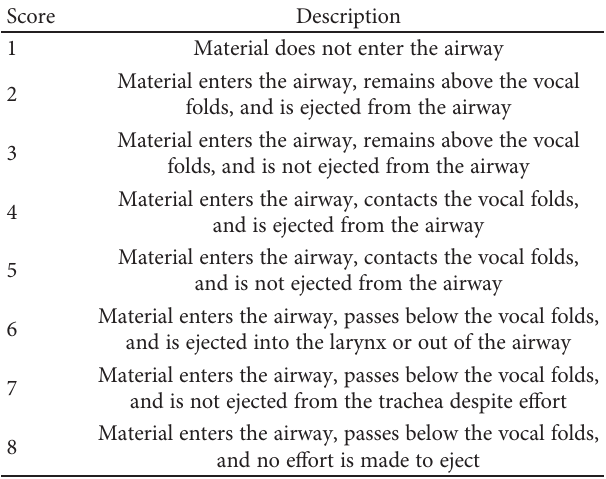
Table 3: Penetration and aspiration scale